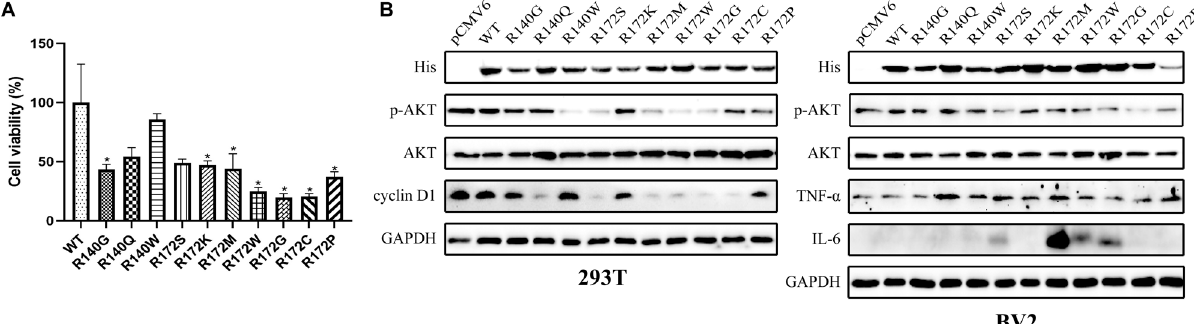
Figure 4. ( A ) Cell viability was evaluated by MTT assay in 293T at day 6 post-transfection with IDH2 WT and mutation constructs. Data were normalized to WT and represent the mean values (± s.d.) of triplicate cultures. All the assays were performed from triplicate experiments. Statistically significant differences between WT and mutants are presented as * p < 0.05. ( B ) Immunoblotting was used to evaluate the expression of IDH2 (His), p-AKT, AKT, and cyclin D1 in the 293T cell line or IDH2 (His), p-AKT, AKT, TNFα, and IL6 in the BV2 cell line at 48 h post-transfection with IDH2 WT or point mutation constructs. GAPDH stain is staining was used as a loading control.